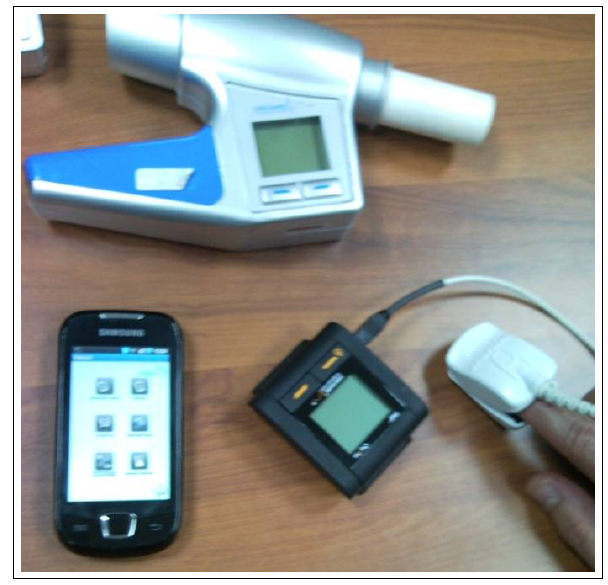
Figure 10. eHealth testbed snapshot. On the left, the Android cluster head of our setting running the Vida24 eHealth application that collects measurements from the oximeter device (on the right). Multiple devices can be paired and monitored, for example, the Spirometer device on the top of the figure.